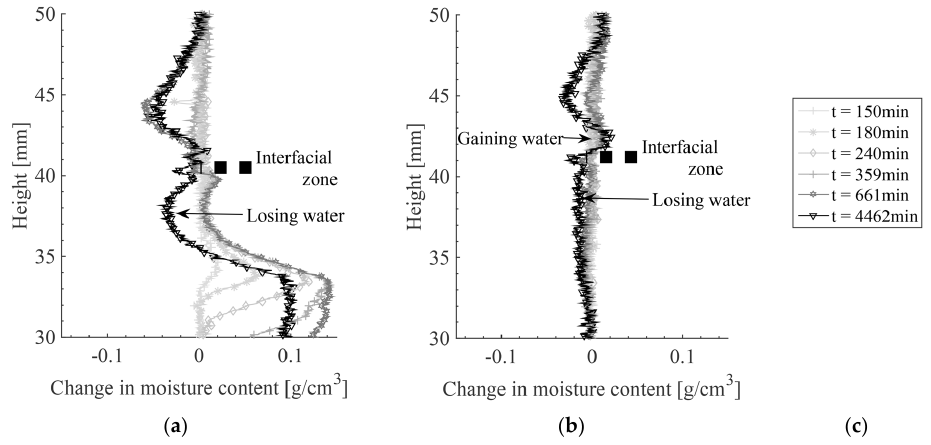
Figure 10. Moisture profiles in the repair systems close to the interface (dashed line): ( a ) dry substrate, w/c = 0.3, DS, S3; ( b ) wet substrate, w/c = 0.3, WS, S3; and ( c ) legend.